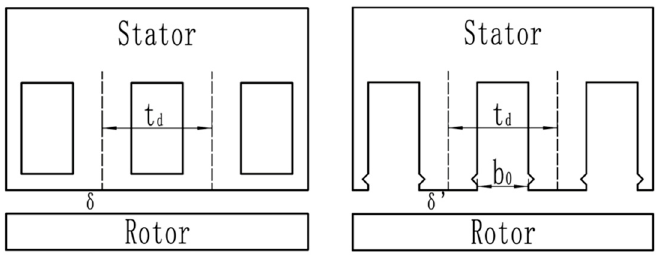
Figure 5. Carter coefficient model.